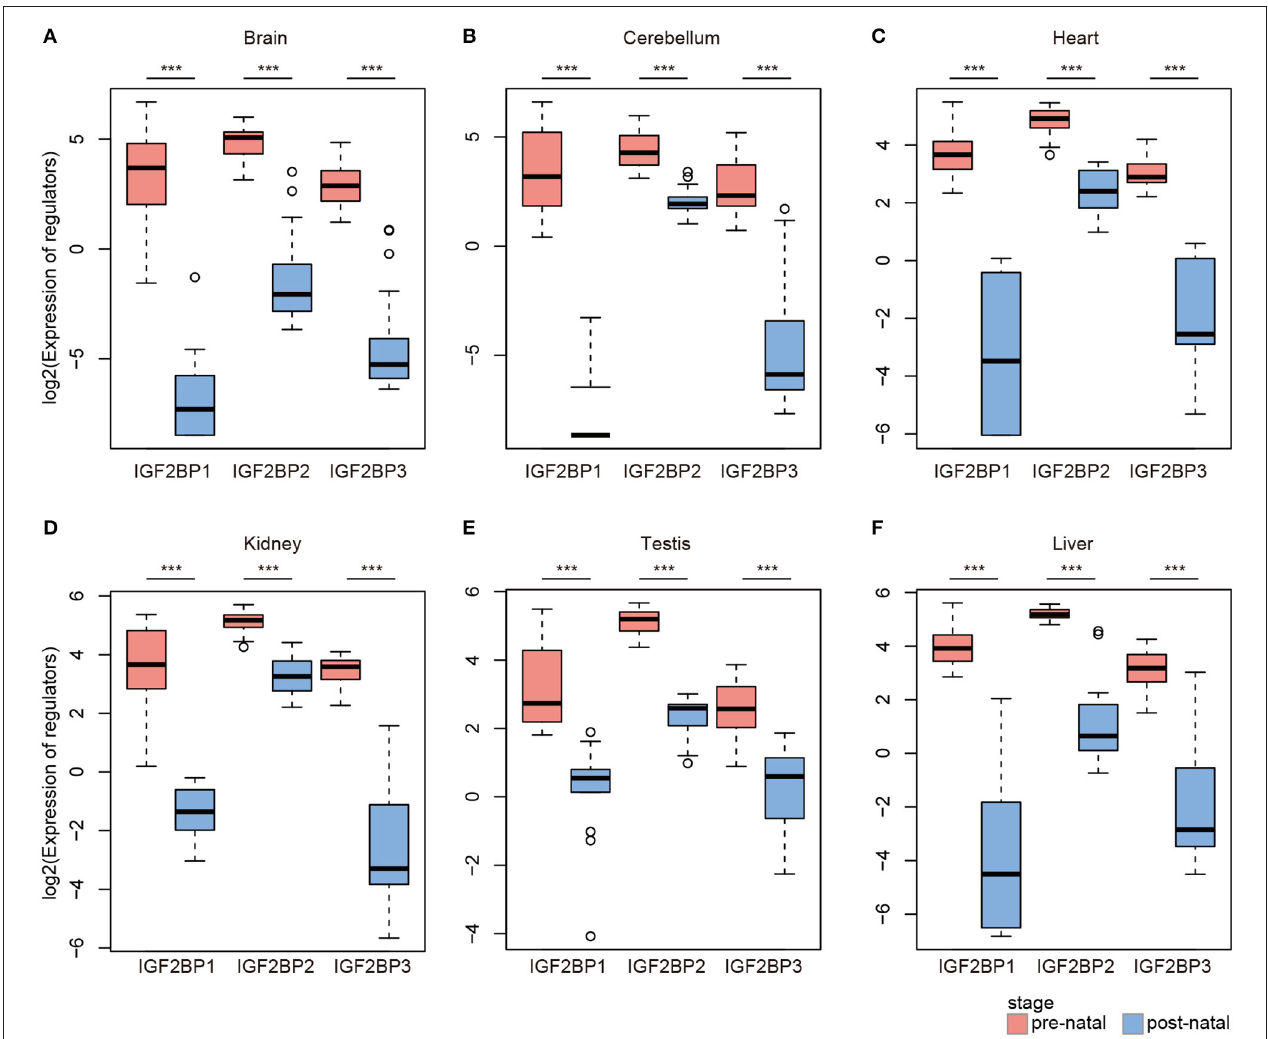
FIGURE 2 | Box plots showing the expression of IGF2BP1/2/3 in prenatal and postnatal samples of different tissues. (A) Expression of IGF2BPs in brain tissues. (B) Expression of IGF2BPs in cerebellum tissues. (C) Expression of IGF2BPs in heart tissues. (D) Expression of IGF2BPs in kidney tissues. (E) Expression of IGF2BPs in testis tissues. (F) Expression of IGF2BPs in liver tissues. *** P < 0.001 for Wilcoxon rank sum